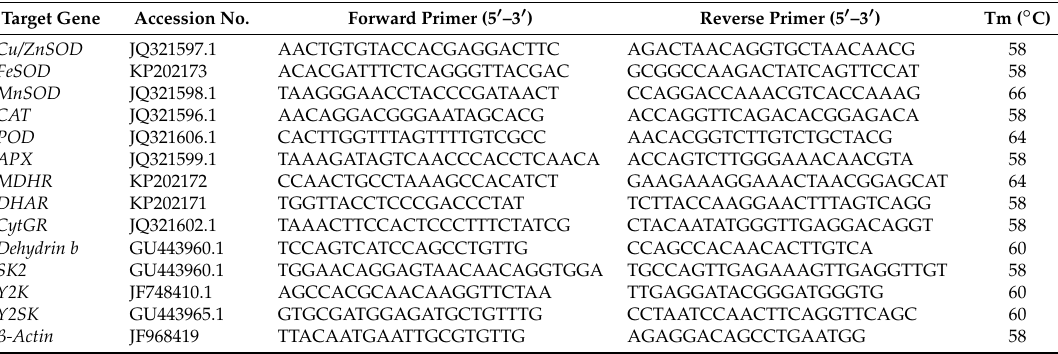
Table 2. Primer sequences and their corresponding GenBank accession numbers of the analyzed genes. Target